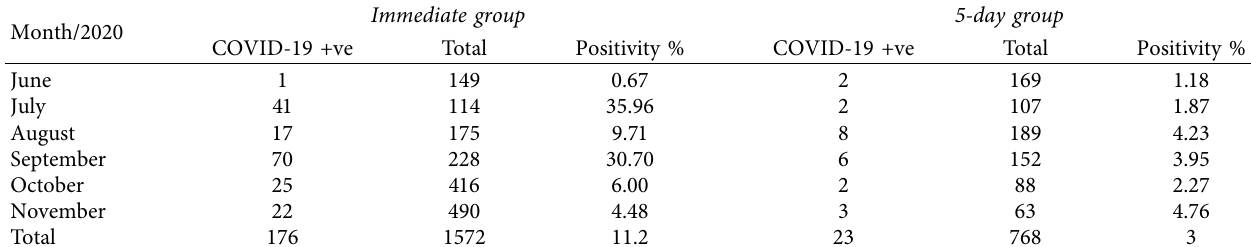
Table 4: COVID-19 positive patients in 5-day and immediate groups preoperatively.